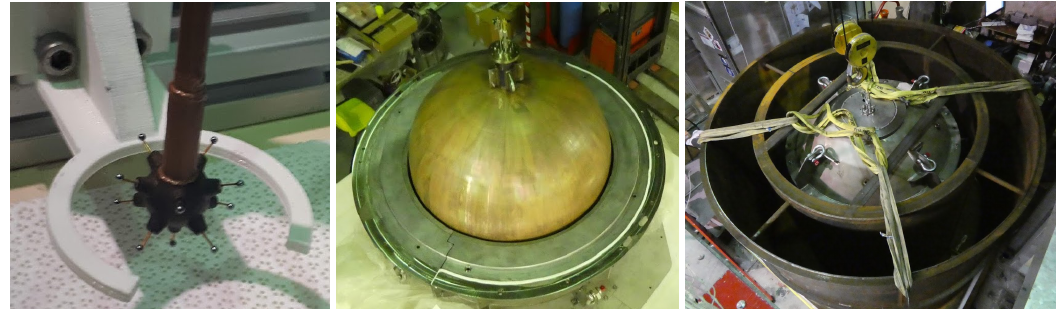
Figure 19: NEWS-G’s S140 setup at LSM (2019). From left to right: ACHINOS anode; S140 sitting on the lower half of the lead shield; S140 in the closed lead shield, inside the open water